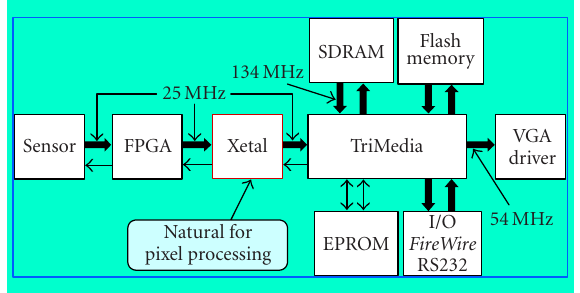
Figure 4: Proposed smart camera